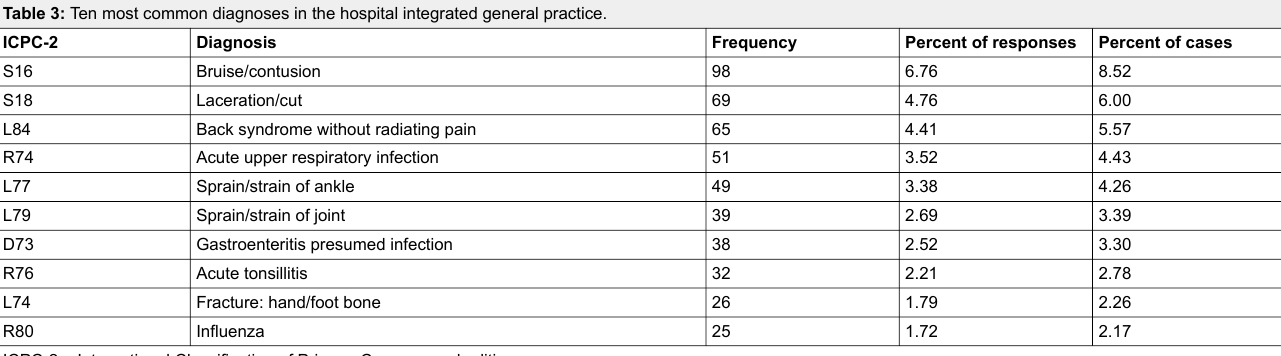
Table 3: Ten most common diagnoses in the hospital integrated general